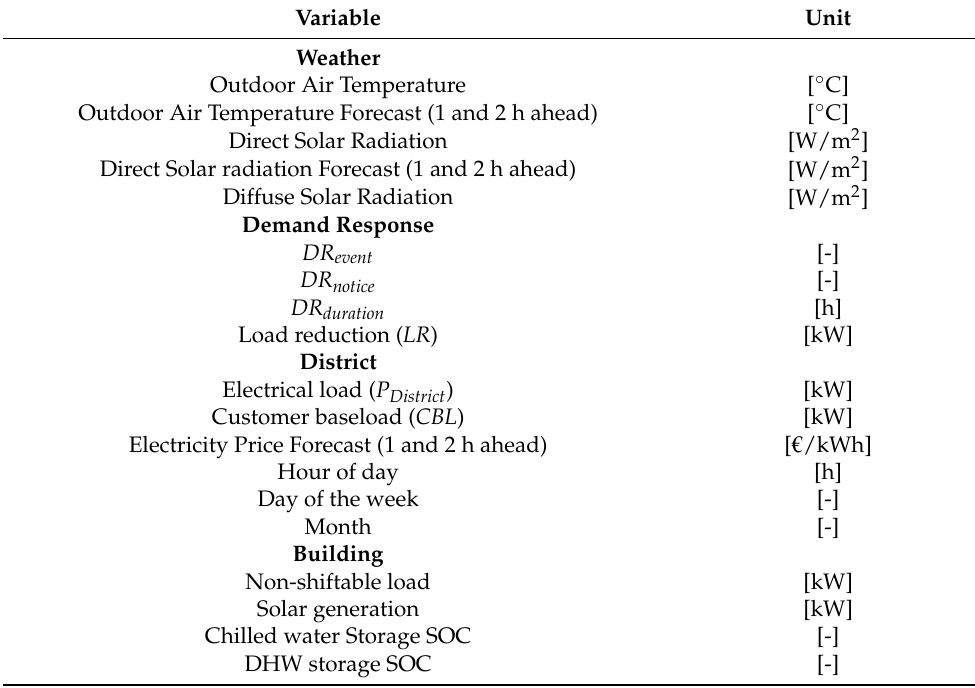
Table 2. State-space